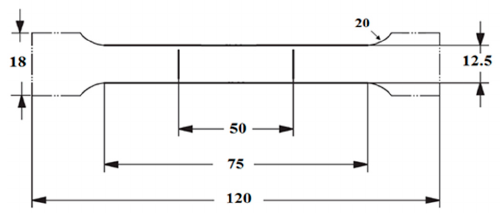
Figure 3. Dimensions of tensile specimen in mm according to BS EN ISO 6892-1:2016 standard.